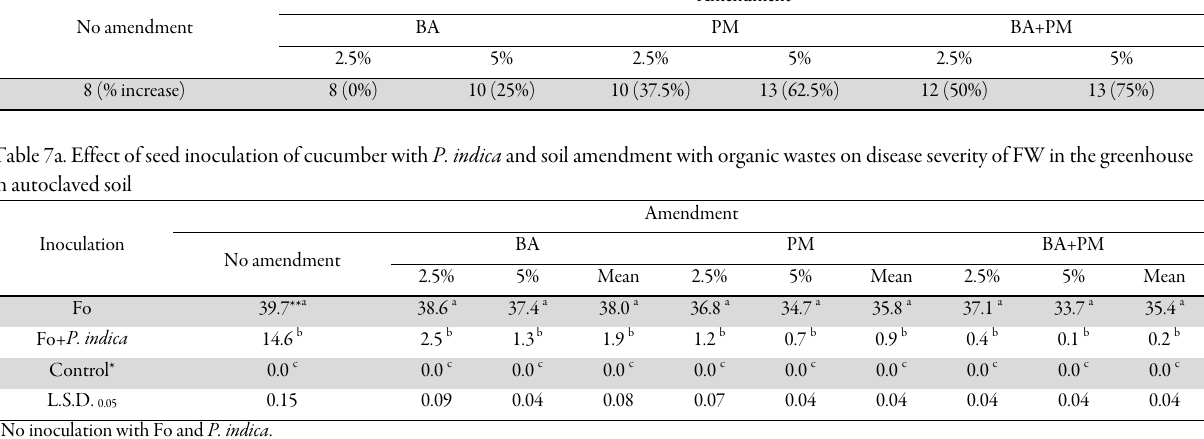
Table 6b. Colonization by P. indica of cucumber roots of 28 day-old plants grown in non-autoclaved soil without or with amendments. The table shows the number of colonized plants determined by light microscopy (n=20)